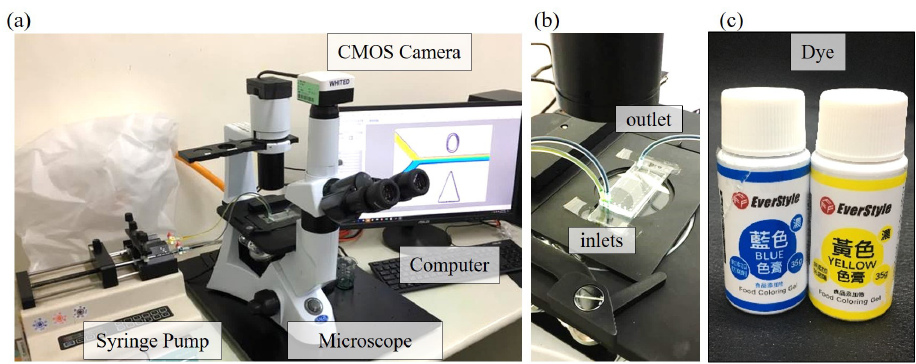
Figure 2. The experimental setup. ( a ) System overview. ( b ) Connections of inlets and outlet on the chip. ( c ) Color dyes for the mixing experiments.